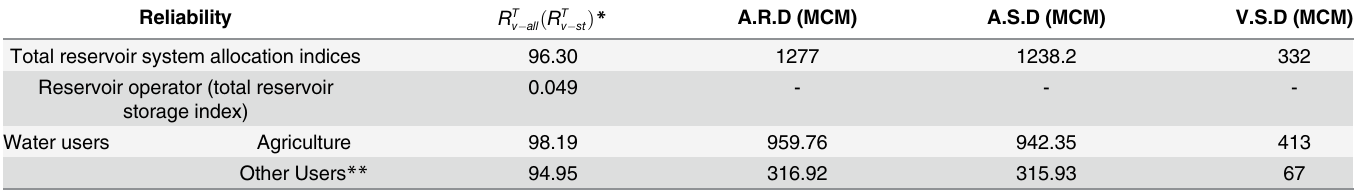
Table 5. The results of simulation based on the outcomes of collocation method working on an annual basis done by Homayoun-far et al. [42].